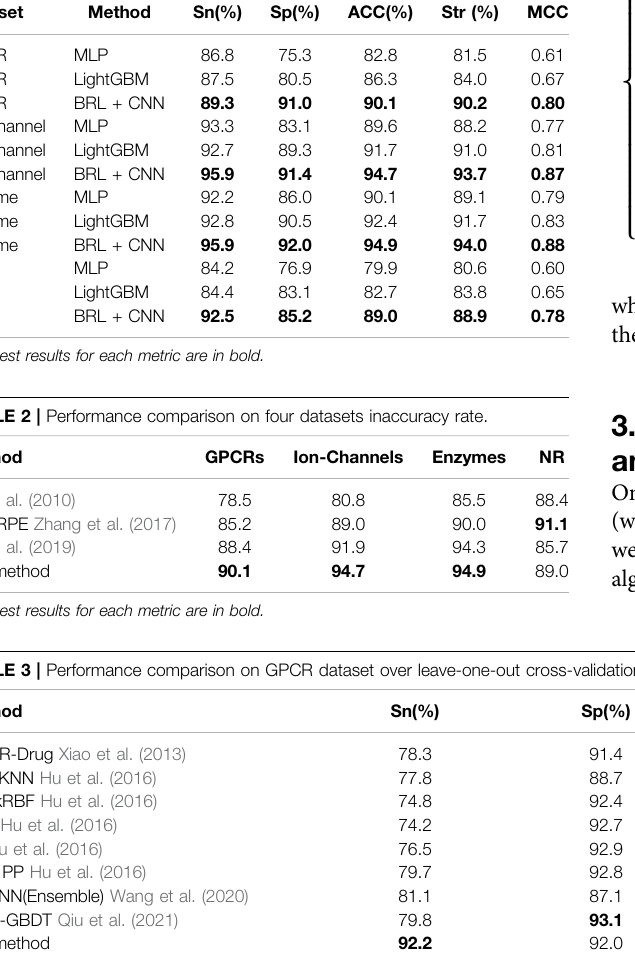
The best results for each metric are in